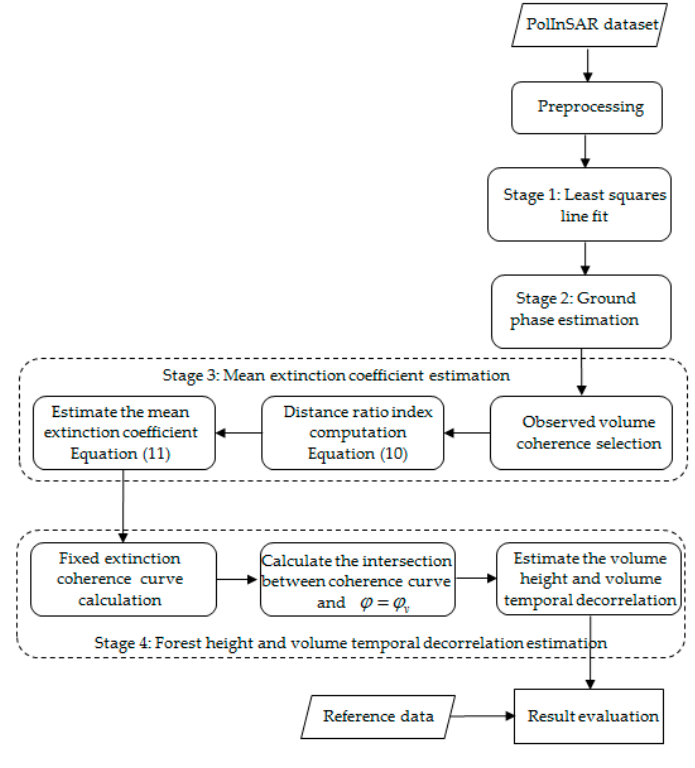
Figure 12. Flowchart of the proposed four-stage inversion algorithm.